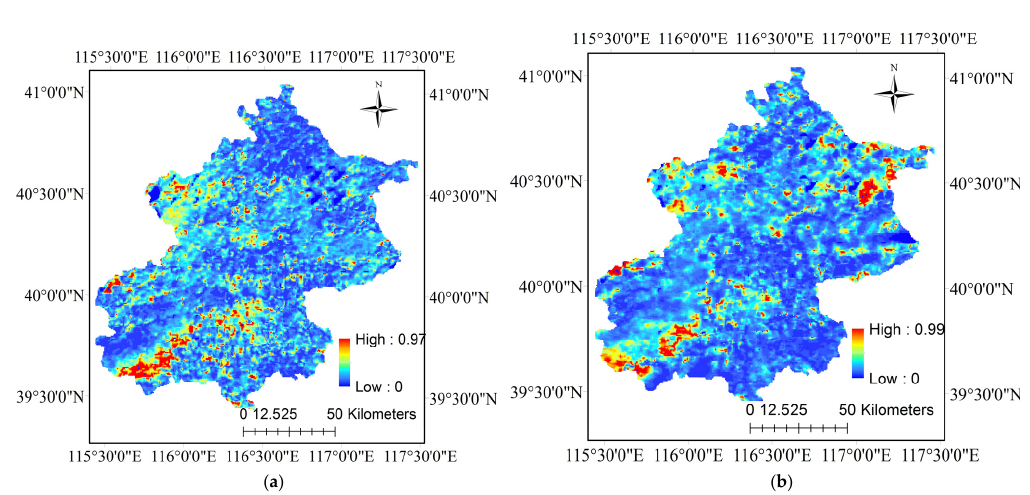
Figure 11. The AOD spatial distribution over Beijing for 500 m resolution. ( a ) The inversion image was acquired on 12 January 2016, and the reference image (‘clear day’) was acquired on 5 January 2016. In this inversion progress, d is set to 25. ( b ) The inversion image was acquired on 25 January 2016, and reference image (‘clear day’) was acquired on 5 January 2016. In this inversion progress, d is set to 45. τ ( t 1 ) is assumed to